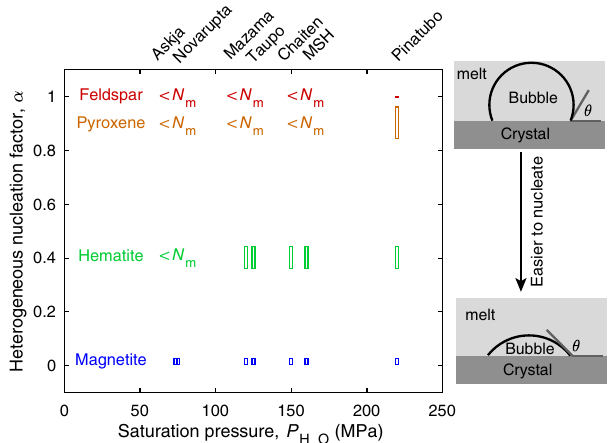
Fig. 2 Heterogeneous nucleation on magnetite reconciles H 2 O saturation pressure with bubble number densities. Heterogeneous nucleation factor, α , required for each eruption to match bubble number densities. Pinatubo can be reconciled with homogeneous nucleation ( α = 1), whereas all other eruptions require heterogeneous nucleation ( α < 1). α shown are for magnetite 20,21 , hematite 21,23 , pyroxene 22 , and feldspar 20 . Magnetite is the only mineral phase that allows heterogeneous nucleation to simultaneously match observed bubble number densities in all